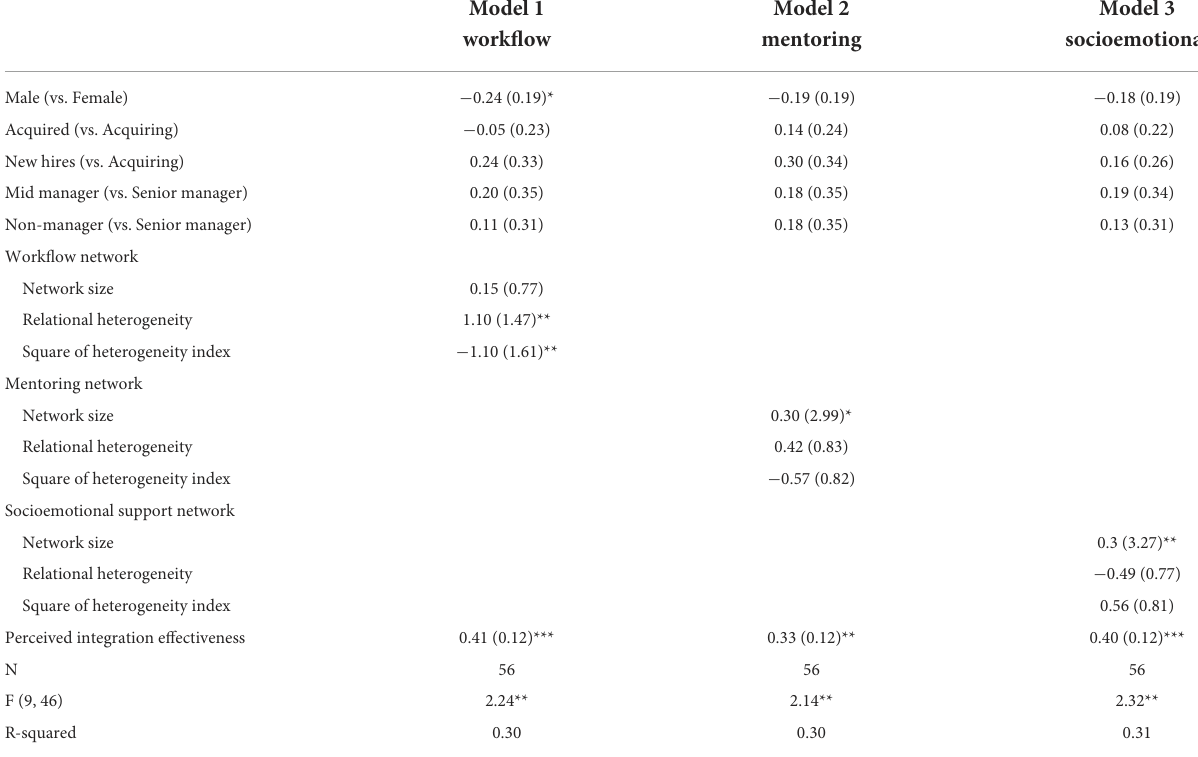
TABLE 3 Standardized regression results of predicting post-merger